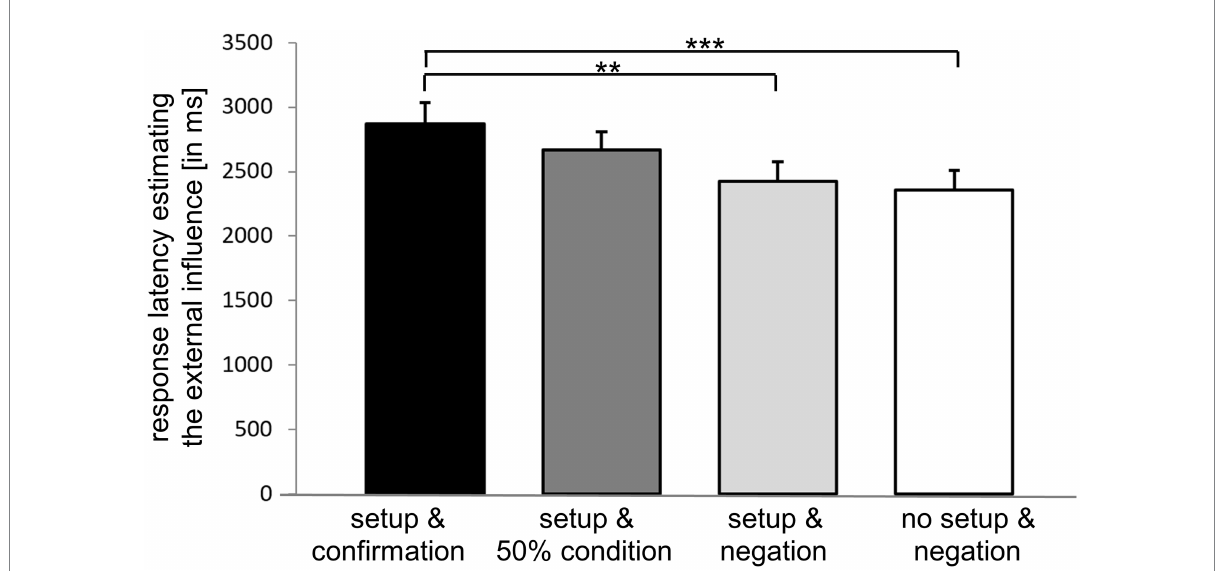
FIGURE 7 Response latencies for estimating the external influence. Conditions are color-coded using “setup & confirmation” (black), “setup & 50% condition” (dark grey), “setup & negation” (light grey) and “no setup & negation” (white). ** p ≤ 0.005, *** p ≤ 0.001. Mean values and standard error of the means are